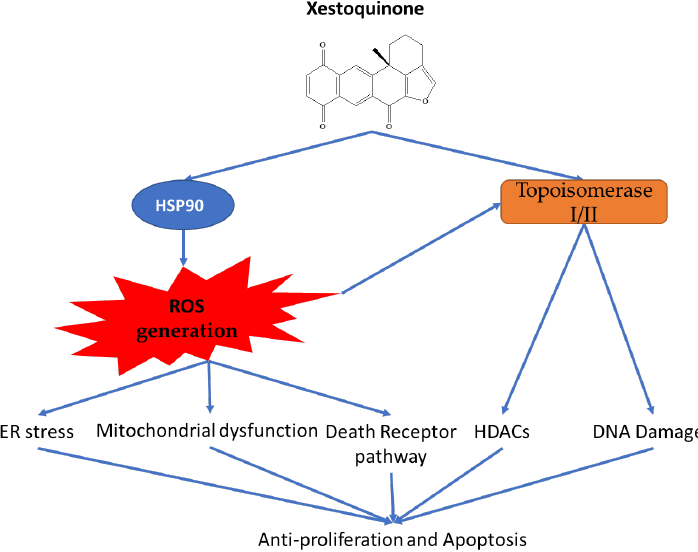
Figure 10. Xestoquinone induced apoptosis in leukemia cells via multiple mechanisms.